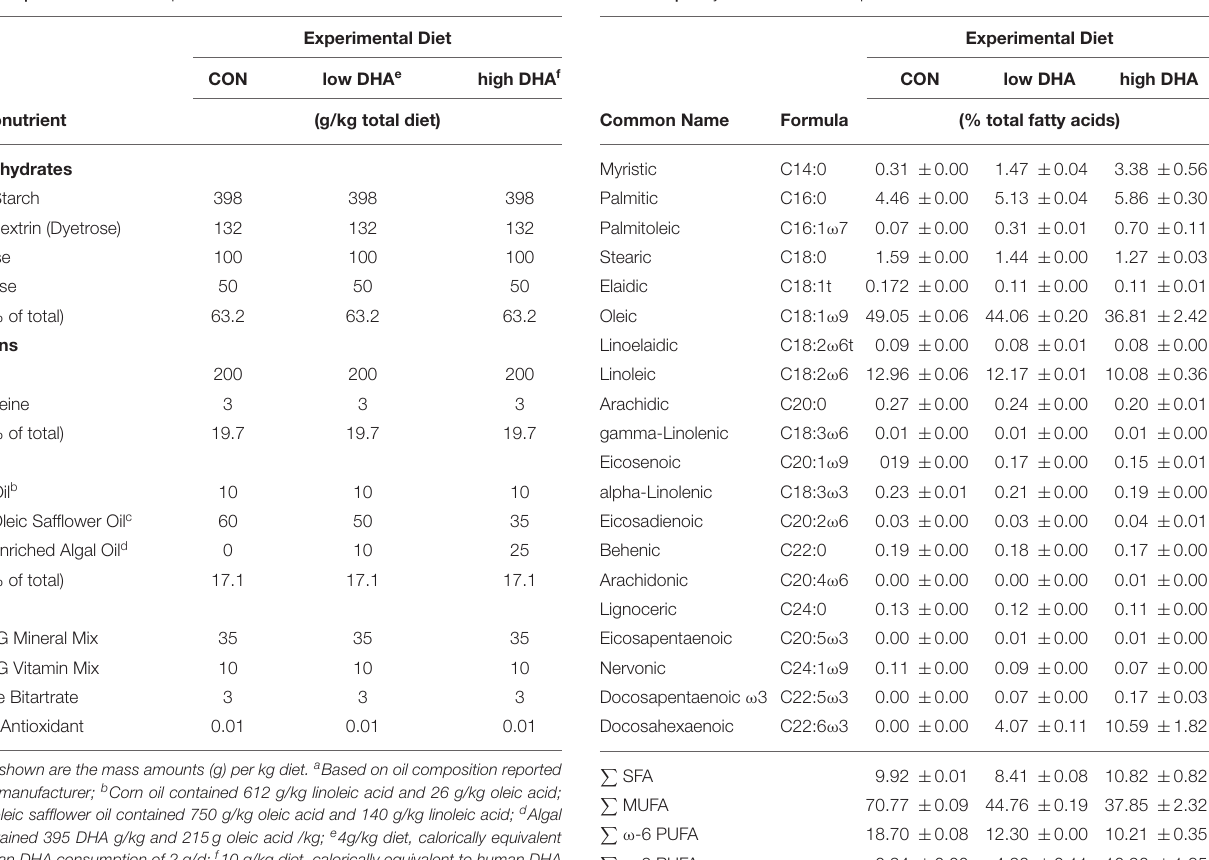
TABLE 1 | Formulations of experimental diets a . TABLE 2 | Fatty acid content of experimental diets.